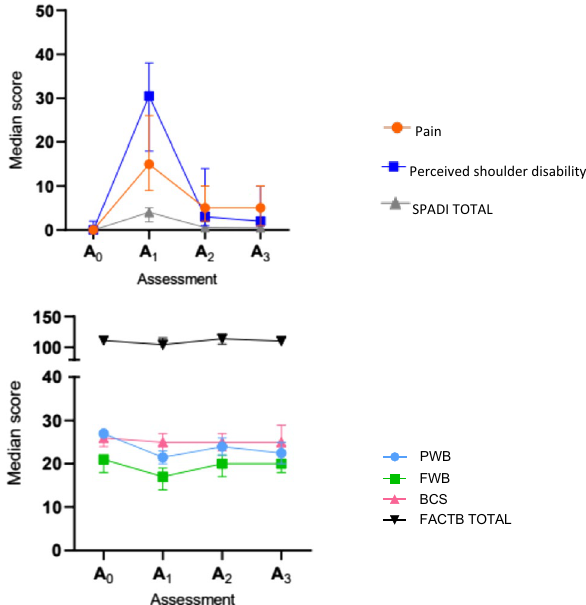
Figure 1. SPADI and FACT-B questionnaires score throughout follow-ups. SPADI Shoulder Pain and Dissability Index Questionnaire, FACTB + 4 Functional Assesment of Cancer Therapy-Breast Questionnaire 4, PWB Physical Well-Being, FWB Functional Well-Being, BCS Breast Cancer Scale A 0 pre-surgical evaluation, A 1 post-surgical assessment, A 2 3 months assessment after surgery, A 3 6 months assessment after